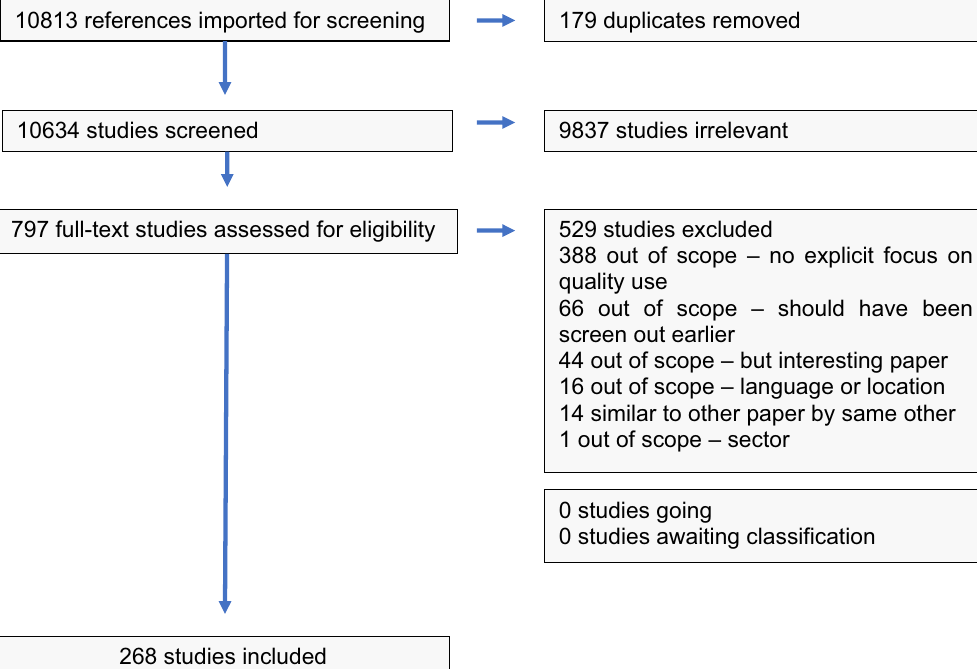
Fig. 1 Prisma diagram generated by Covidence. Prisma diagram showing selection of publications for inclusion in this systematic database